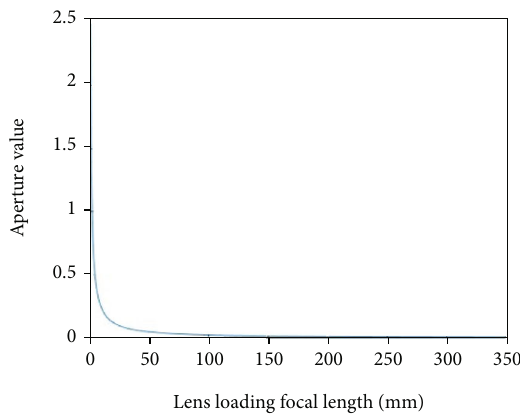
Figure 11: Variation curve of mask focal length f max numerical aperture.